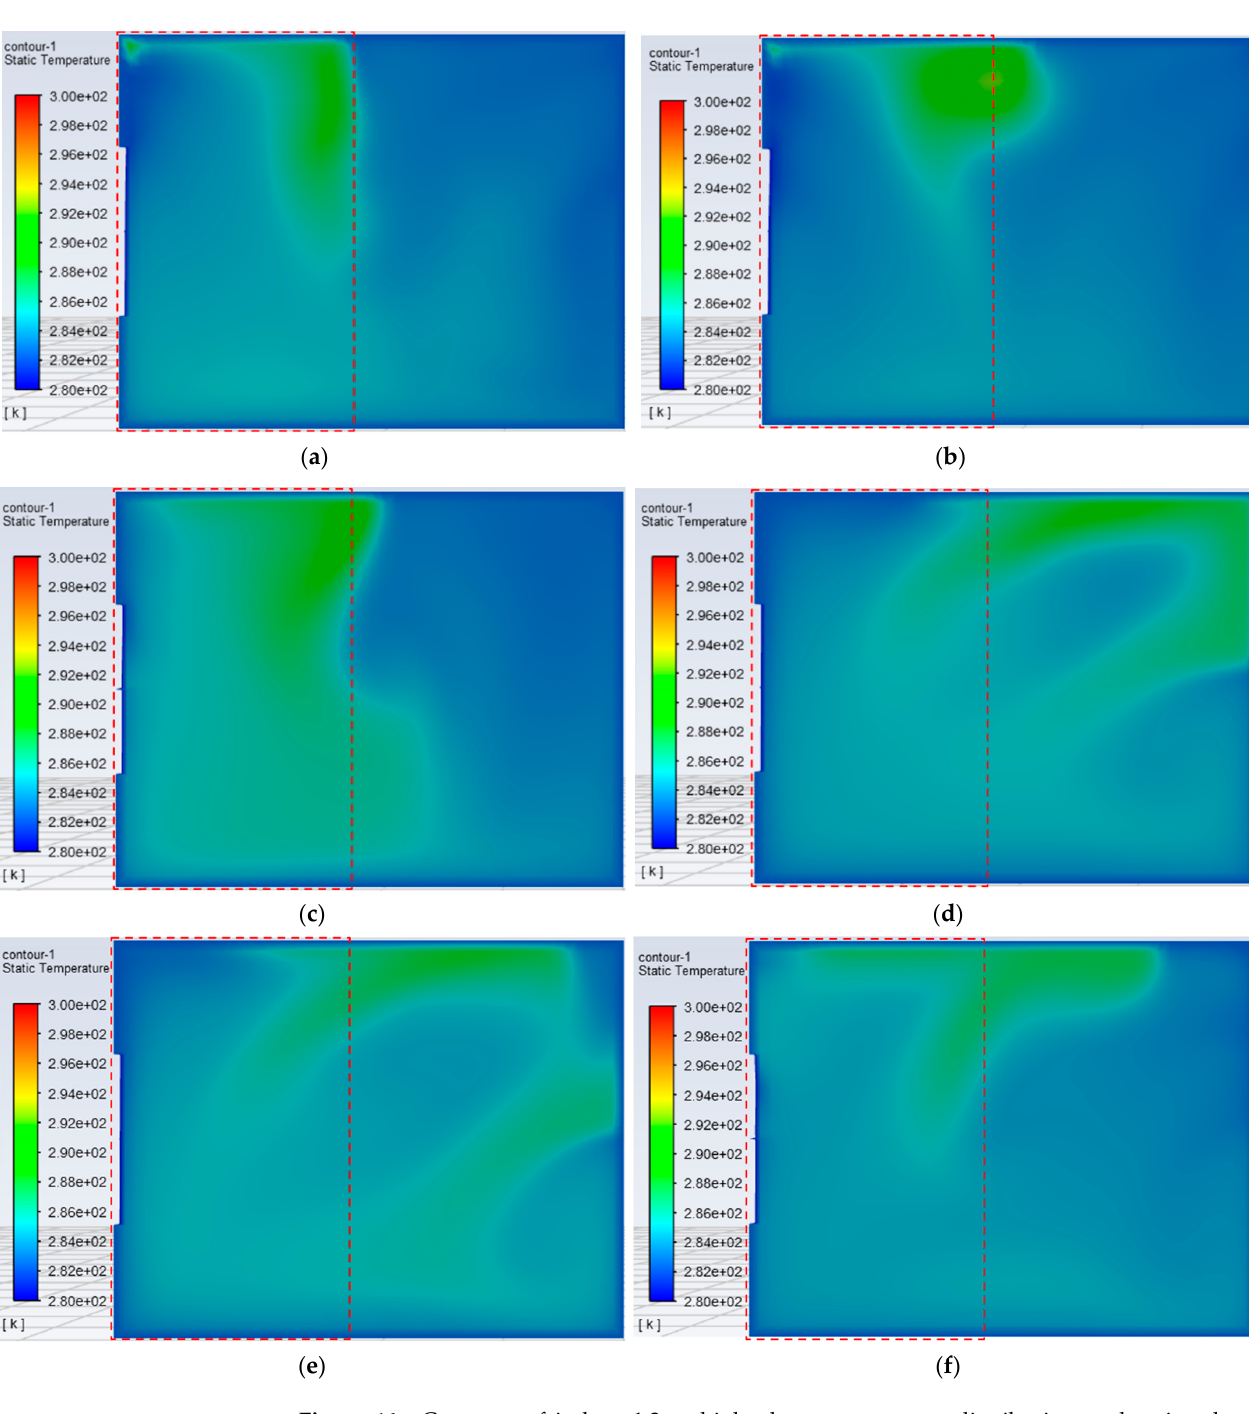
( f ) Figure 13. Contours of indoor 1.2 m high plane CO concentration distribution under six schemes: ( a ) MOUSLE, ( b ) MSUSLE, ( c ) MUSEWP, ( d ) DOUSLE, ( e ) DSUSLE, ( f ) DUSEWP. It can be seen from the FGFAHE experiment that with the increasing of ventilation volume, the supply air temperature gradually decreases. During the time of burning, when the fresh air volume is 29 m 3 /h, the fresh air outlet temperature can reach can reach 3.24~8.4 °C. According to the previous measurement, the average indoor temperature of rural house during PAP is 13.2 °C. Therefore, if the FGFAHE system is used for ventila- tion, when the supply air volume is small, the supply air temperature can be higher than indoor air temperature, which is beneficial to the thermal environment of the bedroom; when the air supply volume is large, the air supply temperature can be lower than the indoor air temperature, which will destroy the thermal environment of the bedroom. In the following section, the indoor thermal environment is discussed by means of simula- tion in two cases of high ventilation (Q = 141 m 3 /h) and low ventilation (Q = 29 m 3 /h). When the air supply volume is Q = 141 m 3 /h, the supply air temperature is set as 8.4 °C according to the FGFAHE experimental results. The ventilation simulation of the room is carried out in the above six ventilation schemes. The temperature distribution contours are generated by intercepting the plane at the height of 1.2 m in the room, and the area where the kang is located is marked with a red frame, as shown in Figure 14.